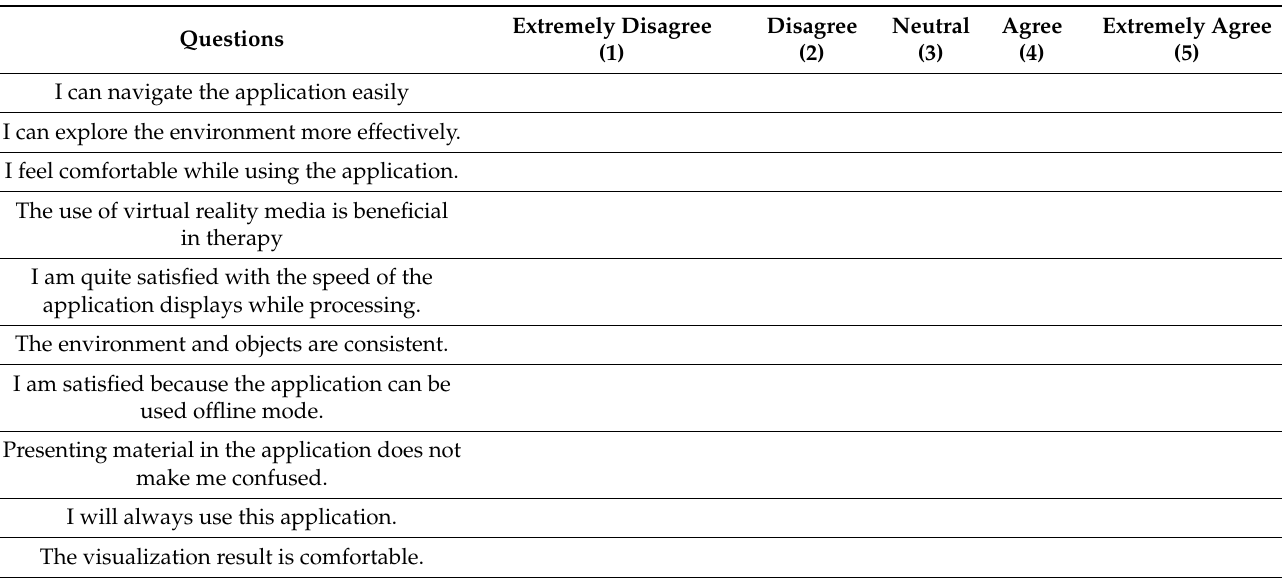
Table A1. The AIVE effectiveness